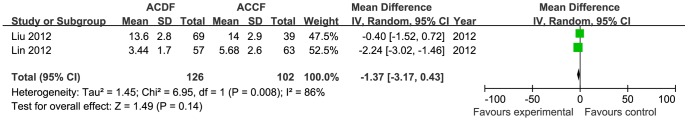
The forest plot for NDI score between ACDF group and ACCF group, CI  =  confidence interval, df  =  degrees of freedom, IV  =  independent variable,SD  =  standard deviation, NDI =  neck disability index.